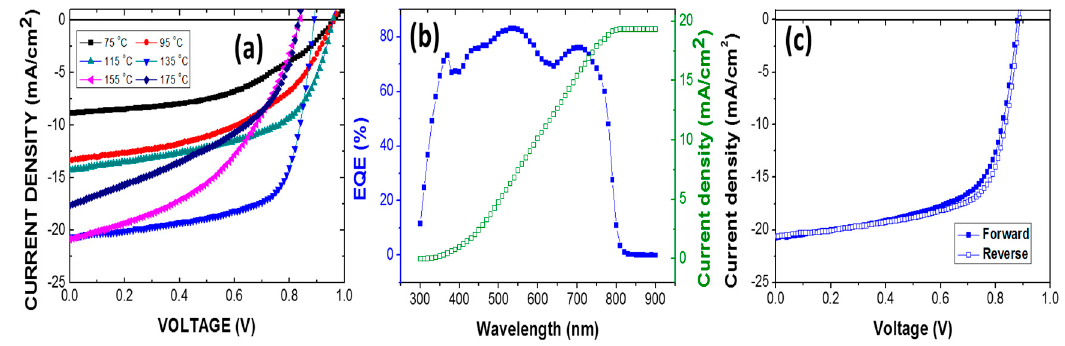
Figure 6. ( a ) Photocurrent J-V curves of perovskite solar cell (Ag/BCP/C 60 /(FAPbI 3 ) 0.8 (MAPbBr 3 ) 0.2 /PEDOT:PSS/ITO) obtained under standard 1 sun AM 1.5 simulated solar irradiation; ( b ) IPCE spectrum and ( c ) J-V curves of best device under forward and reverse scanning.